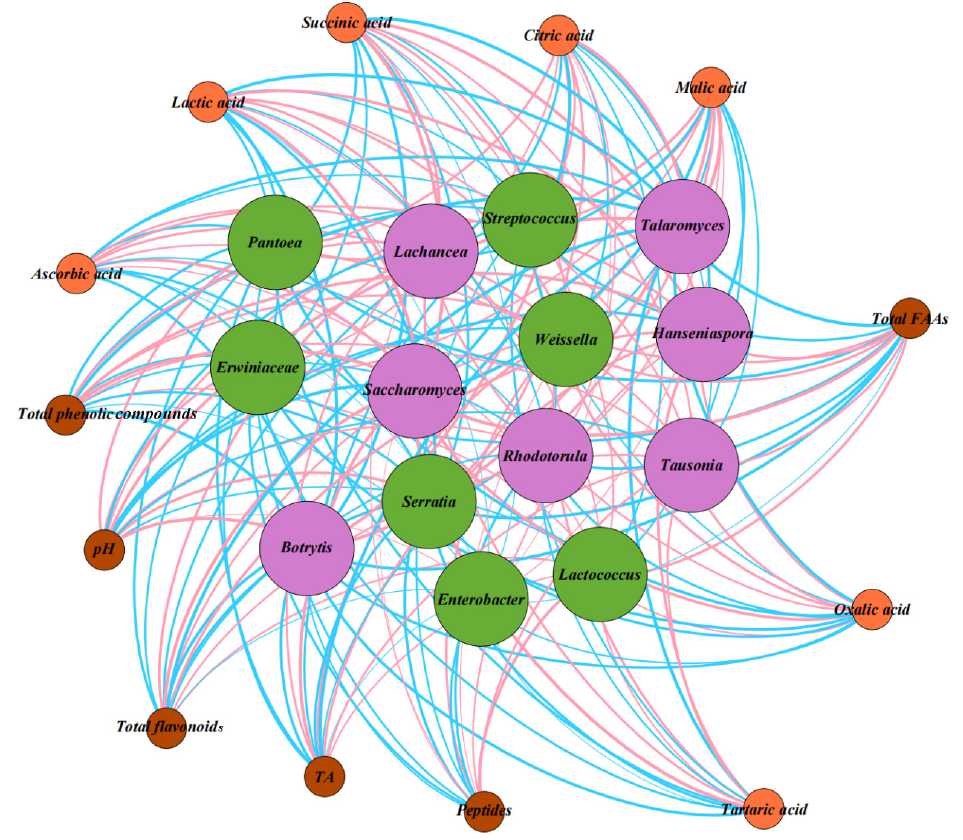
Figure 3. Correlation between microbial genera, organic acids, total free amino acids and physico- chemical properties. Note: the red line connecting the circles indicates a positive correlation, while the blue line indicates a negative correlation between the microbiota and the indicator.